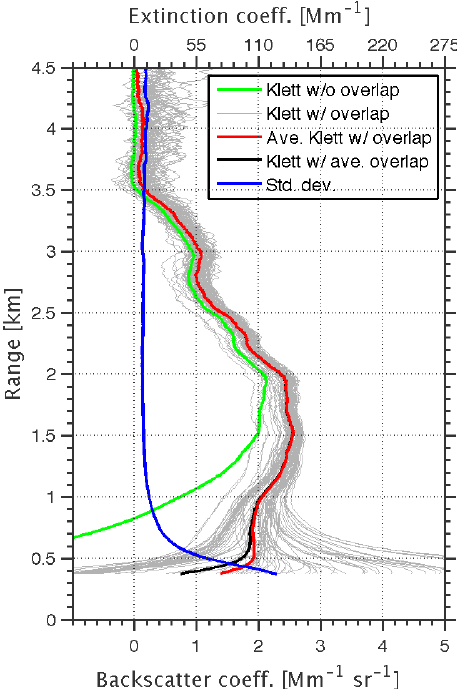
Figure 6. Backscatter coefficient obtained with the Klett algorithm without overlap correction (green) and with the average overlap (black) are shown. The backscatter coefficient obtained for each of the 90 overlaps measured with a narrow field stop (gray), their average (red) and standard deviation (blue) are also shown. Data from 1 September 6:30 pm to 2 September 5:00 am was used. The extinction scale on top was scaled with LR = 55 sr .